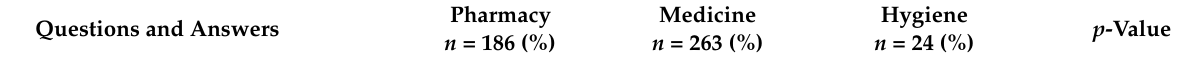
Table 5. Perceptions regarding the content and composition of vaccines.